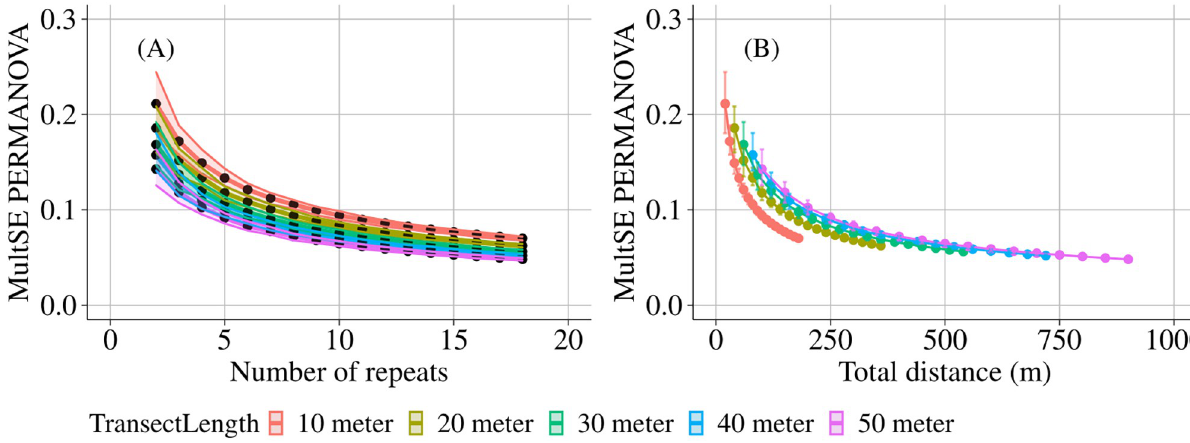
Fig 5. Multivariate precision estimates of fish assemblage structure. Multivariate pseudo error variance (multSE) of PERMANOVA analysis based on Bray-Curtis dissimilarities (fourth-root transformed) with Island as fixed factor and Location and Transect as nested random factors. Monte Carlo simulations (n = 10 4 ) were applied to determine the multSE per number of repeats. The average values over all transects are visualized. The error bars represent the 95% confidence intervals which were constructed using the pooled standard deviation of the estimates.